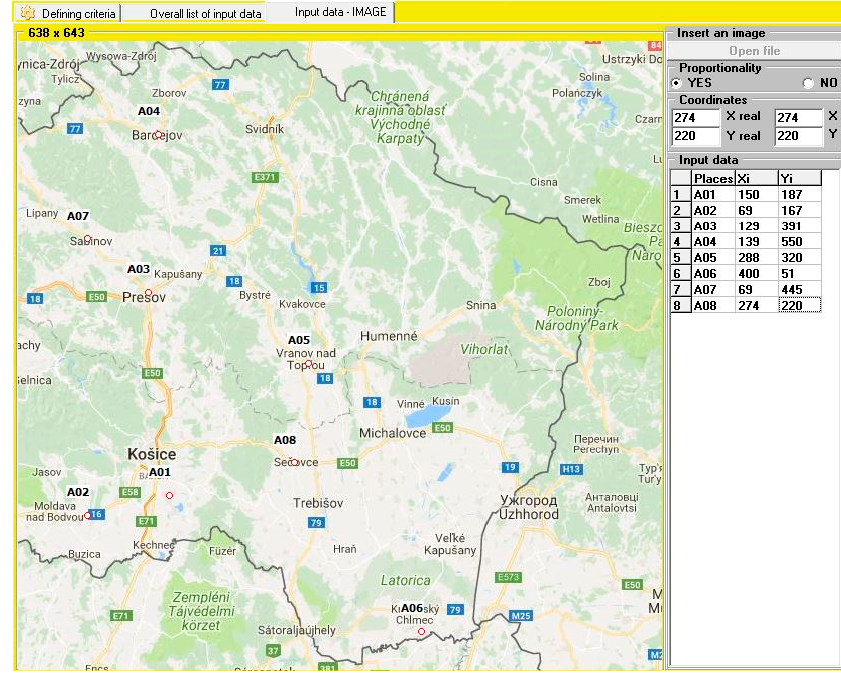
Figure 14. Positions of the places of supply of GAMA, Inc. Secovce in eastern Slovakia. Table 4. Defined coordinates of the places of supply in the calculation, and their unit quantities, unit prices, selected